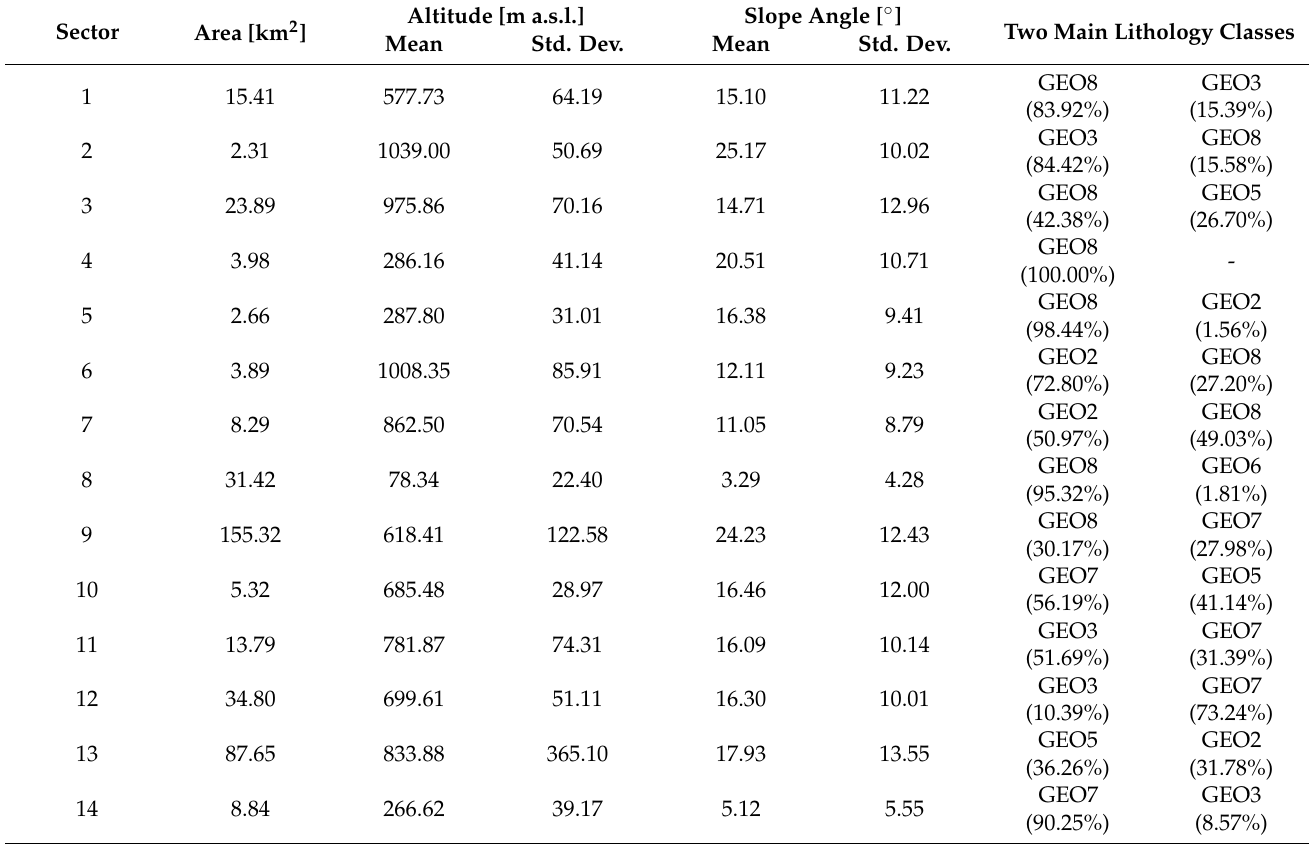
Table 1. Extent, average and standard deviation of altitude and slope angle and the main outcropping lithology classes. GEO1: incoherent soils/rock (alluvial, marine and lacustrine deposits); GEO2: soft rocks (intermediate basic effusive rocks and subordinate pyroclastites); GEO3: hard rocks (intermediate basic effusive rocks); GEO4: medium rocks (acid effusive and acid intermediate rocks); GEO5: very soft soils (Tierra Blanca: acidic pyroclastites, subordinate volcanic epiclastites and acid effusive rocks); GEO6: soft soils (quaternary sedimentary deposits); GEO7: hard soils (acid